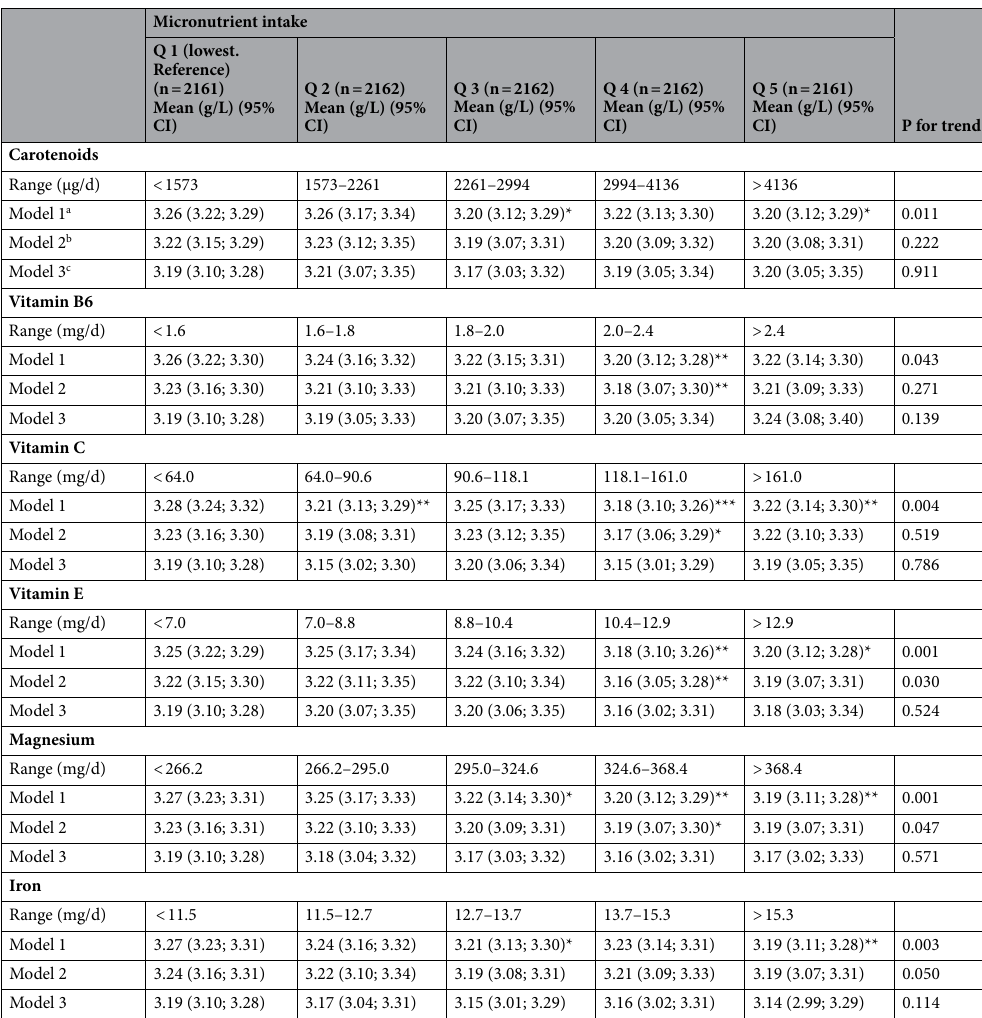
Table 3. Geometric means of plasma concentration of fibrinogen by quintiles of micronutrient intake in the ENRICA study (N = 10,808). *p ≤ 0.05 **p < 0.01 ***p < 0.001. P values for differences in plasma fibrinogen levels across quintiles of micronutrients intake (quintile 1 as reference) using the above linear regression models. a Model 1: linear regression model adjusted for age and sex. b Model 2: adjusted as model 1 and for educational level (≤ Primary, Secondary, University), smoking status (never smoker, former smoker, current smoker), heavy drinking (yes, no), leisure-time physical activity (quintiles of METs-h/w), energy intake (quintiles of kcal/d), Body Mass Index ≥ 30 (yes, no), chronic lung disease, cardiovascular disease, cancer, depression, hypercholesterolemia, diabetes, hypertension and rheumatoid arthritis (yes, no). c Model 3: adjusted as model 2 and for fibre (quintiles of intake), carbohydrates (quintiles of intake), unsaturated fats (quintiles of intake), sodium (quintiles of intake) and all other micronutrients in the table (quintiles of